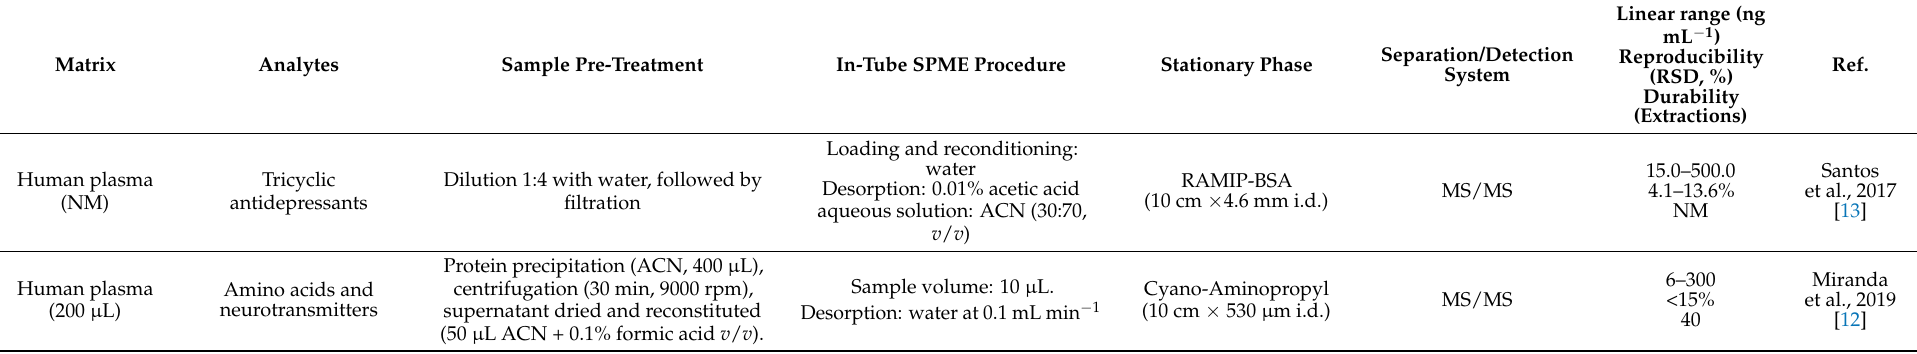
Table 3. In-tube SPME directly coupled to MS systems and its